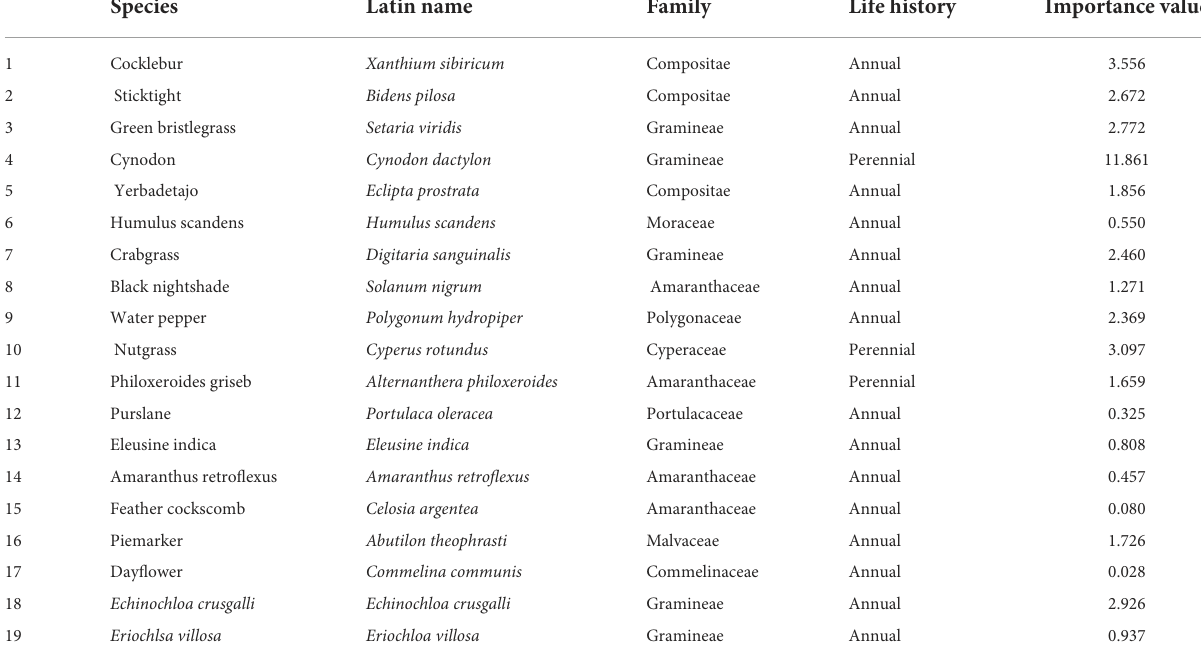
TABLE 3 List of tested species for leaf functional traits. Species Latin name Family Life history Importance